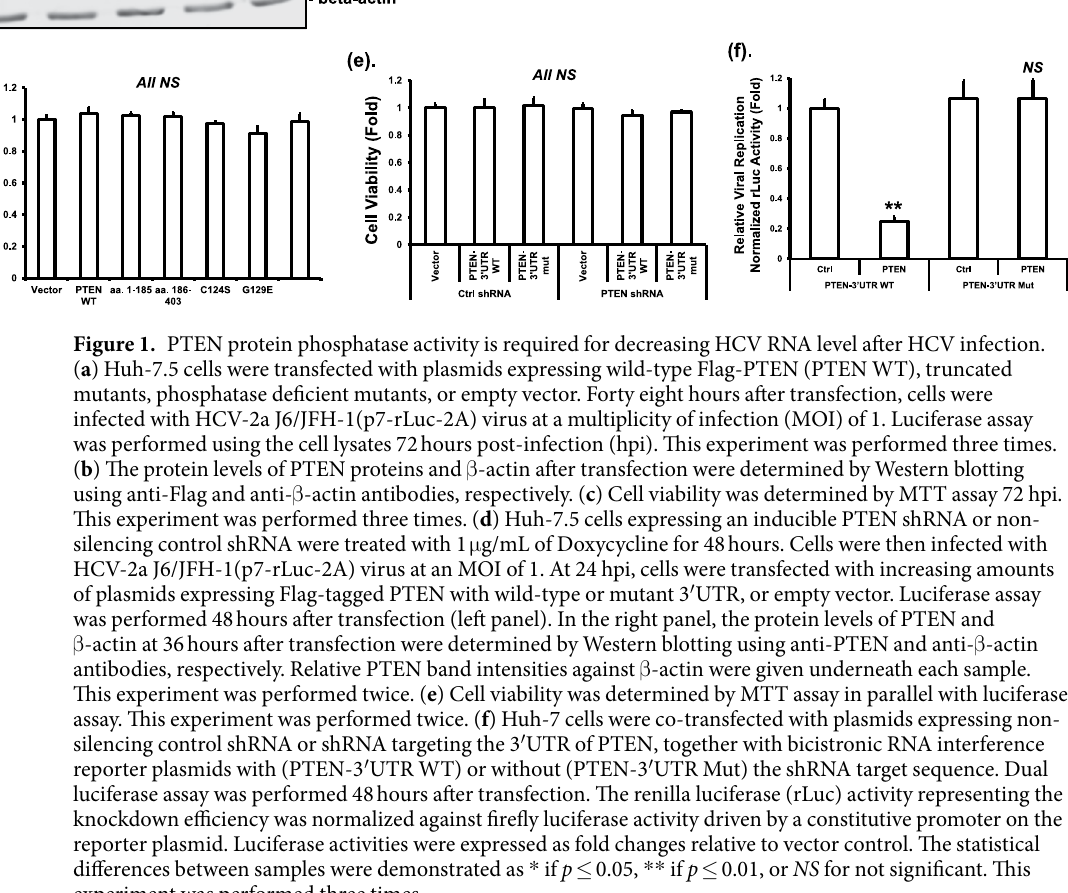
replication (Fig. 3a and b). PTEN protein expression was confirmed by Western blotting (Fig. 3c). These data suggested that the protein phosphatase activity of PTEN is essential for the inhibition of HCV RNA replication. To study the roles of viral structural and non-structural proteins in HCV replication inhibition by PTEN, we determined the effects of PTEN on the replication of an HCV subgenomic replicon. We found that PTEN did not inhibit HCV replication in the absence of HCV structural proteins (Fig. 3d for luciferase levels and 3e for HCV